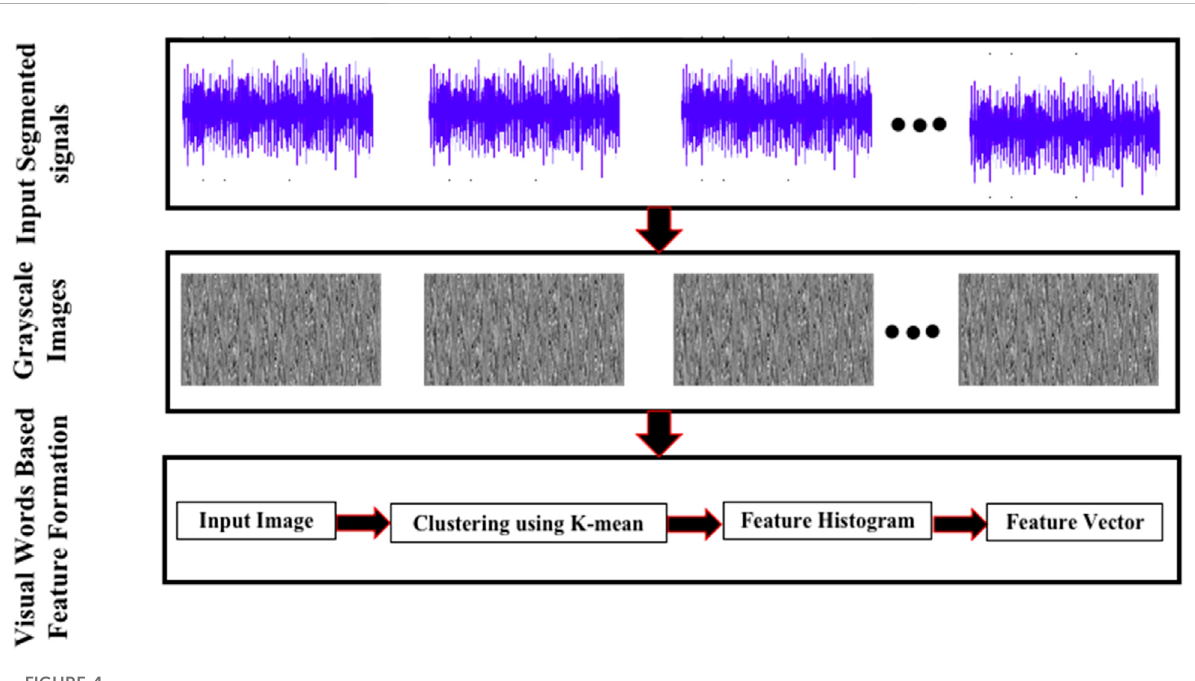
FIGURE 4 An illustration of the bag of visual words representation from the input